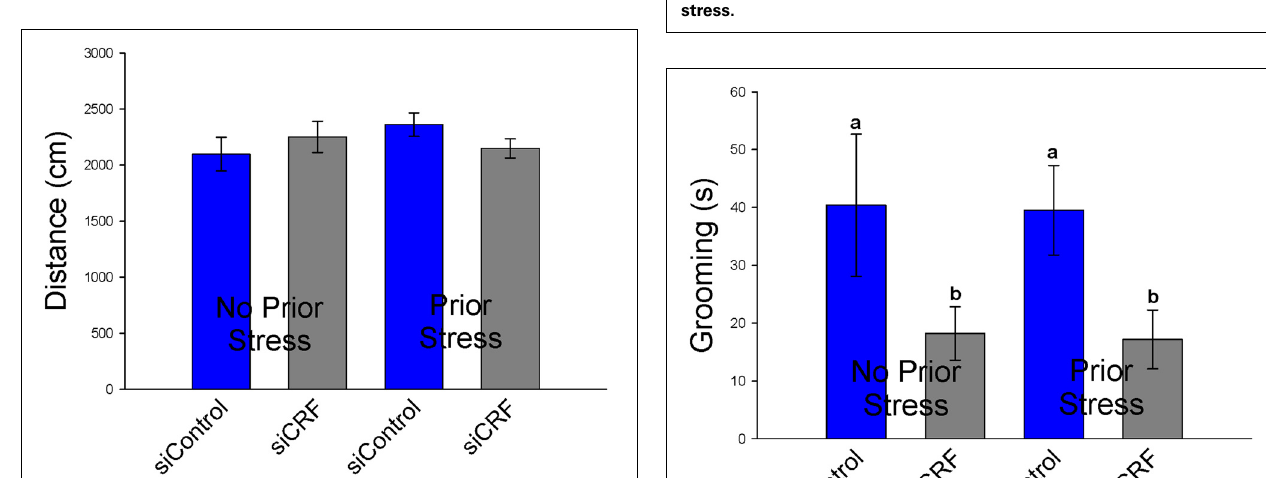
FIGURE 6 | Distance traveled (cm ± SEM) in Open Field was not significantly altered by siCRF treatment or restraint stress.